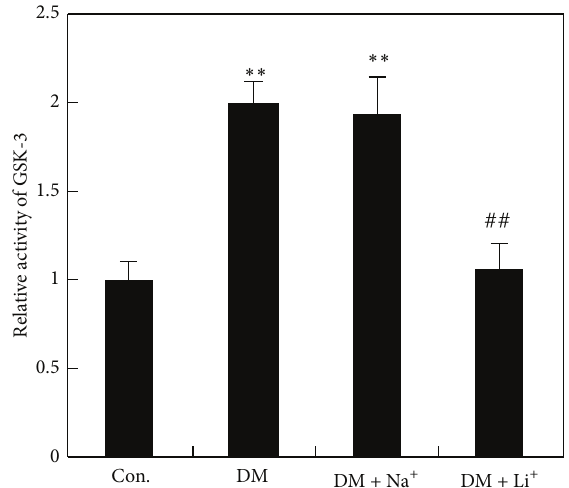
Figure 1: The level of serum glucose of the rats. 72 h following streptozotocin injection, the levels of serum glucose in DM group,